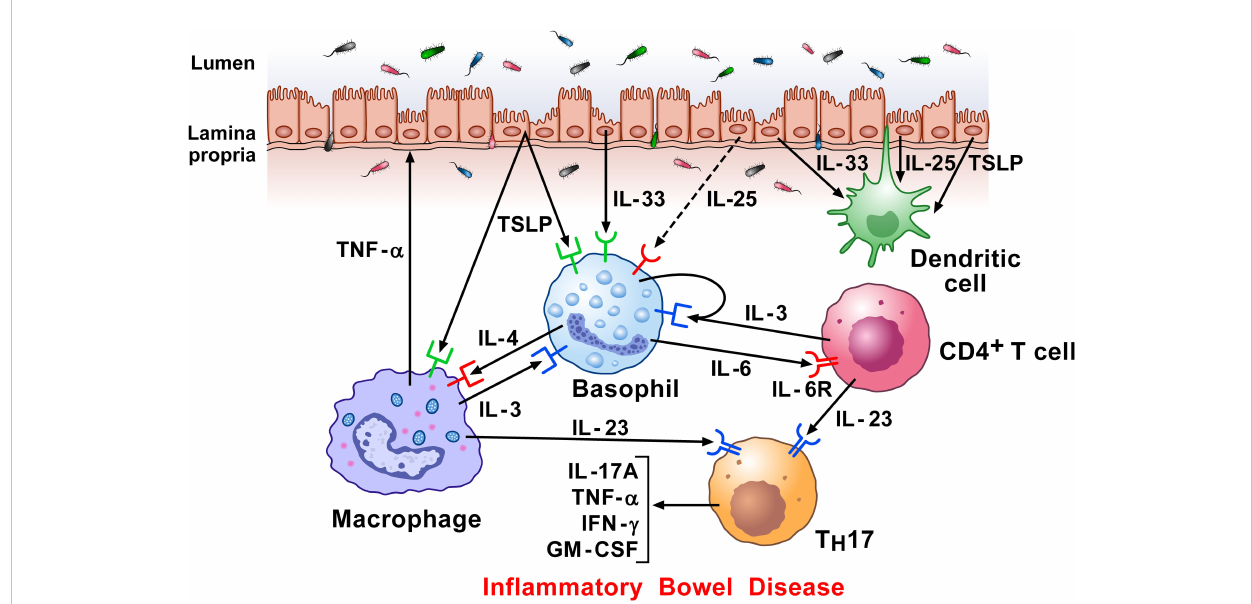
FIGURE 6 Hypothetical mechanisms by which dysregulated epithelial cells and in fl ammatory signaling by lamina propria immune cells in response to microbiota, contribute to in fl ammatory bowel disease (IBD) pathogenesis. Intestinal epithelial cells separate the lamina propria and deeper tissues from the luminal environment containing the intestinal microbiota (239). Increased intestinal permeability can potentiate immune-mediated systemic and intestinal in fl ammation in IBD (240). Damaged epithelial cells release alarmins (IL-33, TSLP, and IL-25) (115, 123, 241), which then regulate underlying immune cells (242), including basophils (9), macrophages (157), and DCs (243). Macrophages can damage epithelial cells directly by TNF- a secretion. Basophils accumulate in in fl amed IBD compared to non-in fl amed mucosa and to colon of healthy controls (125). Activated T cells in fi ltrate in fl amed colons and release IL-3 which can contribute to the attraction and/or survival of basophils locally (238). Speci fi c components of gut microbiota induce the emergence of intestinal T H 17 cells. Basophils may also promote T H 17 responses (125). Activated T cells release